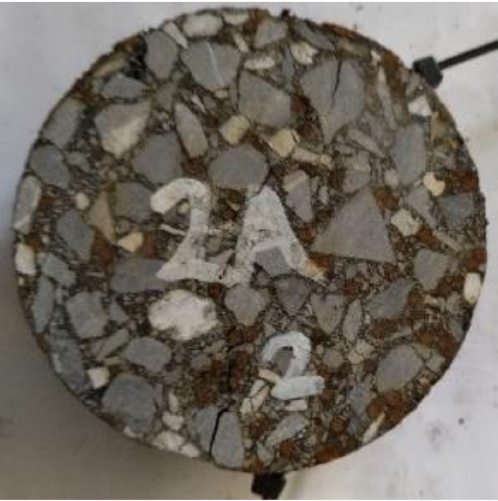
Figure 8. The 10 mm SMA test specimen containing 5% capsules ready for induction healing.